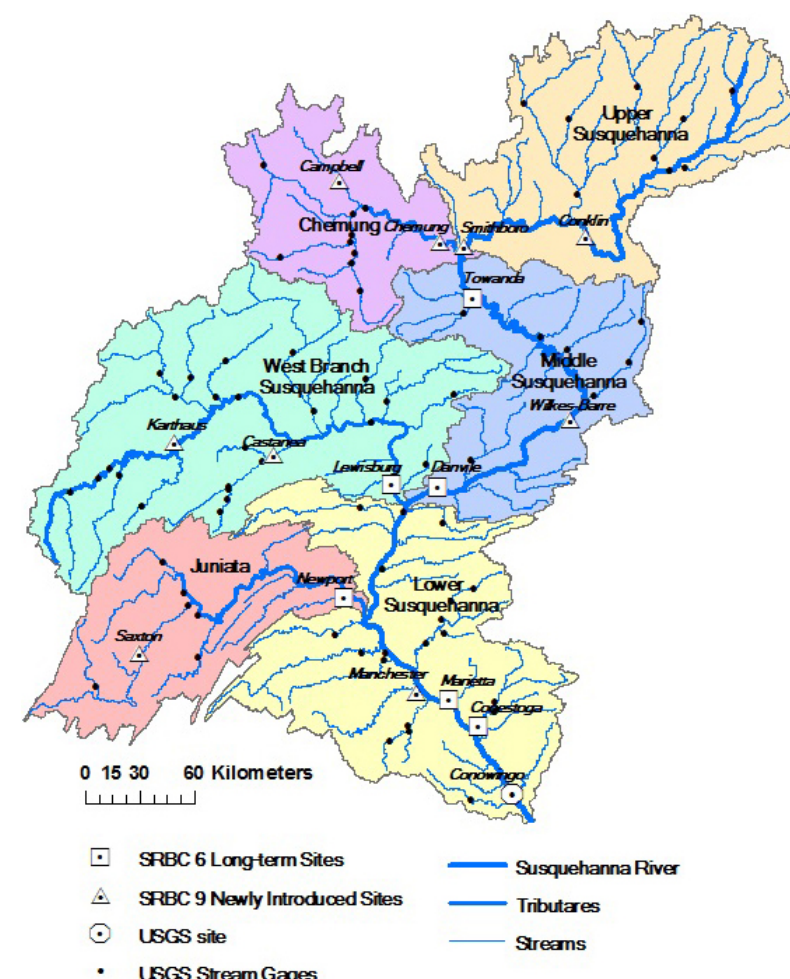
Figure 3. Map of the Susquehanna watershed, showing six major sub-basins, main stem of the Susquehanna River, major tributaries (Chemung, West Branch Susquehanna, and Juniata River), streams, and the location of USGS stream gauges and USGS and SRBC nu- trient monitoring